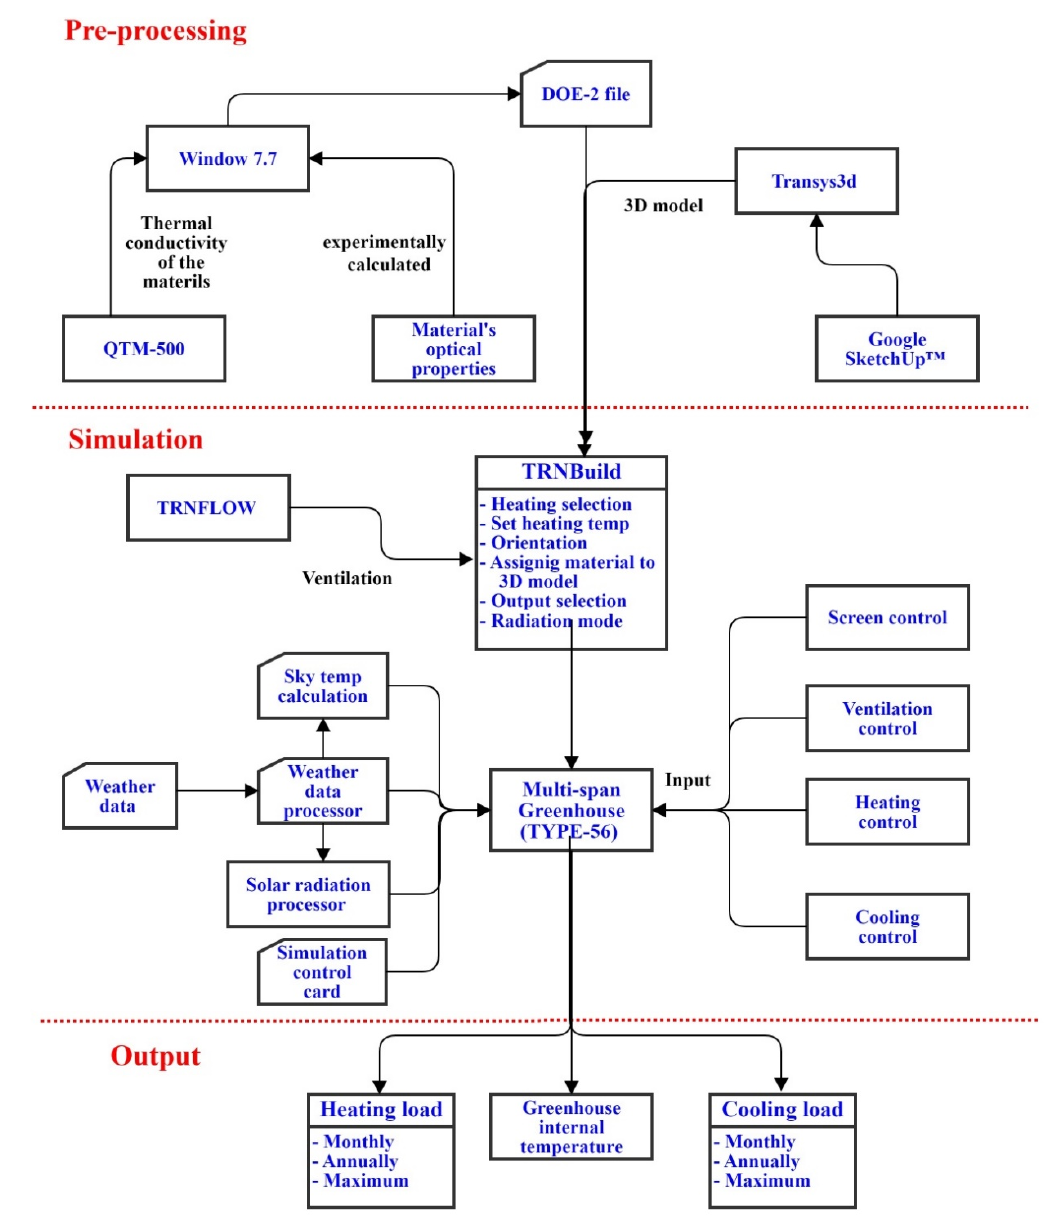
Figure 6. Flow diagram of multi-span greenhouse building energy simulation (BES) model.